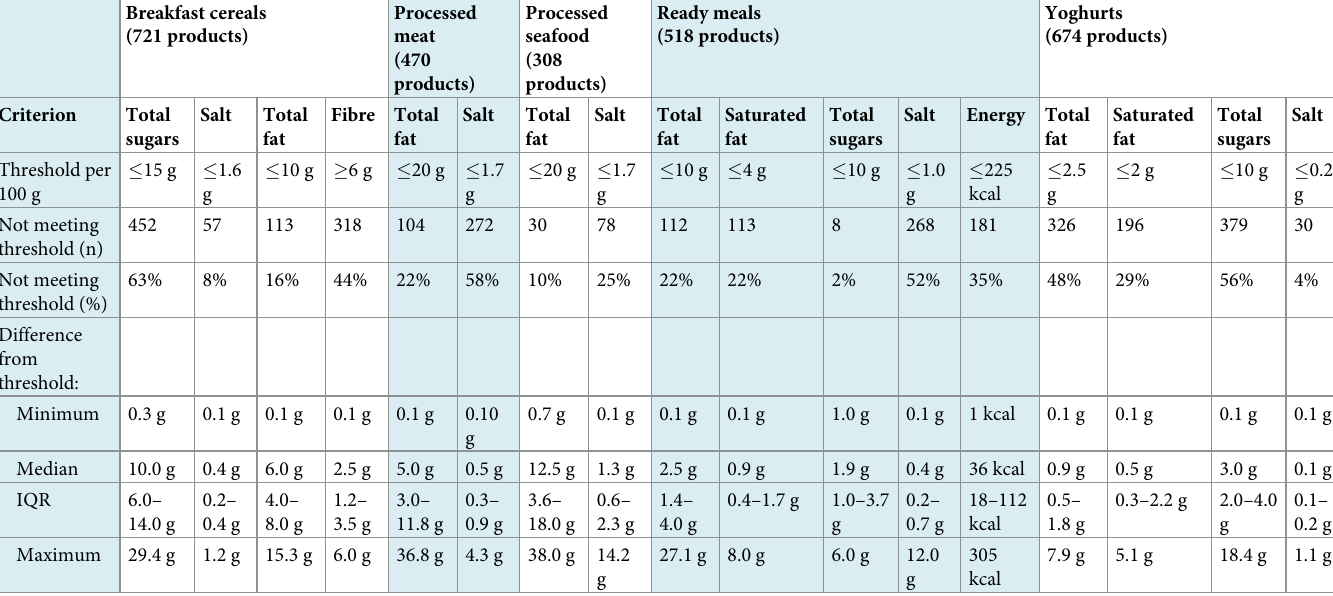
Table 5. Assessment of the minimum, median, and maximum difference from applicable nutrient/energy thresholds in five product categories from the Euromoni- tor Nutrition 2016 database using the WHO Europe nutrient profile model. Breakfast cereals (721